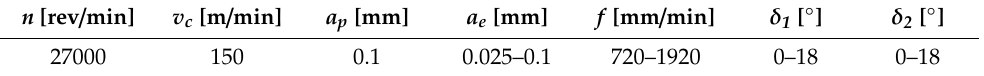
Table 4. The range of variation and the values of the adopted cutting process data.